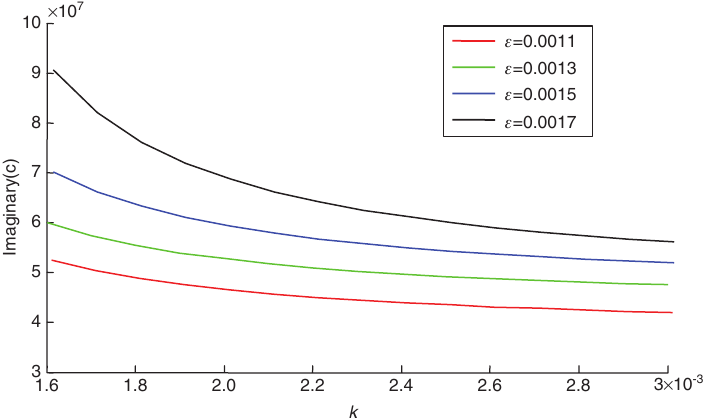
Figure 3 Variation of the phase velocity Imaginary(c) against the wave number k for a fixed depth h = 15